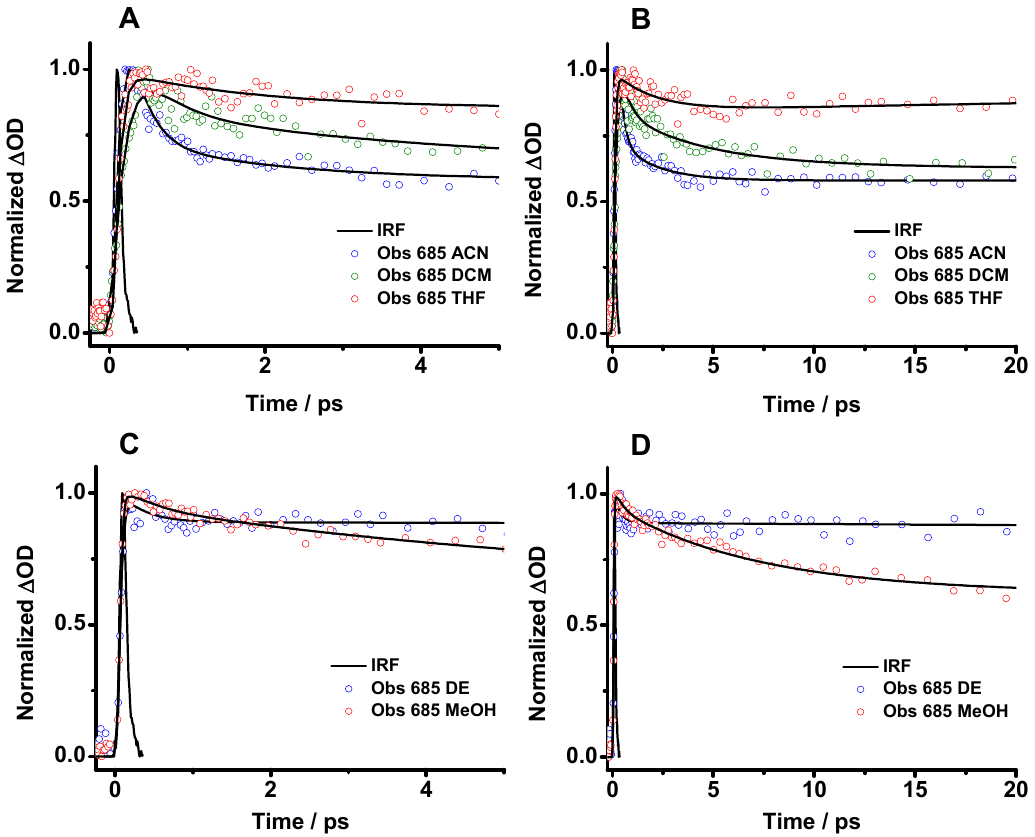
Figure 6. Femtosecond transient absorption decays of Me 2 CANADC in ( A , B ) ACN, DCM and THF and ( C , D ) DE and MeOH at different time windows. The solid lines are from the best multiexponential fits (see Table 3). The decays were recorded at 685 nm, and the samples were excited at 420 nm.